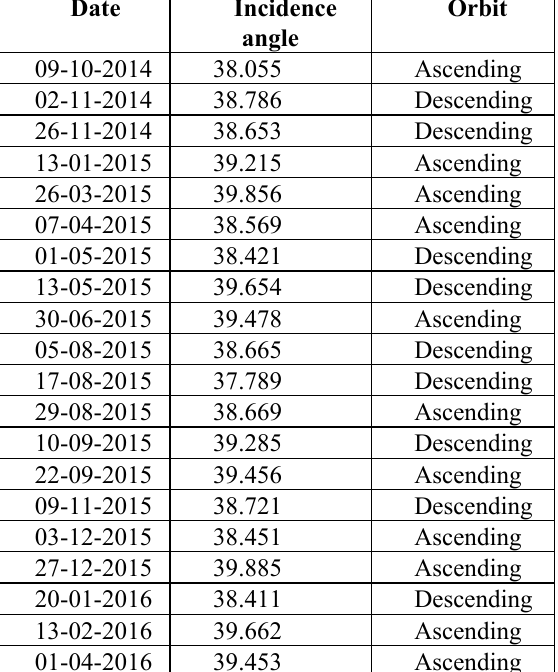
Table 1: Sentinel-1 imagery used in this